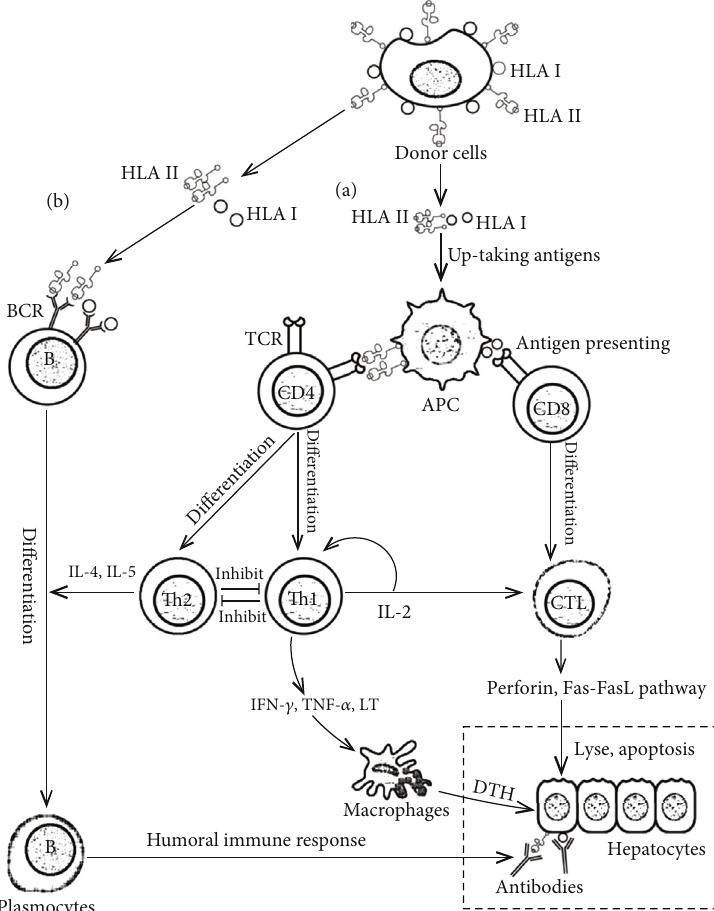
Figure 1: The mechanism of immune rejection after liver transplantation. (a) Immune rejection mediated by cellular immunity. Antigen- presenting cells (APCs) recognize and uptake the foreign antigens from donor-derived cells and present them to T cells, in which CD4+ T cells are activated and di ff erentiate into various e ff ector T cells, such as T helper 1 (Th1), Th2, and cytotoxic T lymphocytes (CTLs). Th1 cells can induce CD8+ T cells to di ff erentiate into cytotoxic T lymphocytes (CTLs) via secreting IL2, and CTLs can secrete perforin to directly lyse hepatocytes or induce target cell apoptosis through the Fas-FasL pathway. On the other hand, Th1 cells can secrete interferon-gamma (IFN- γ ), tumor necrosis factor alpha (TNF- α ), and lymphotoxin to corrupt liver grafts via delayed-type hypersensitivity (DTH), in the process of which macrophages may be a primary participant and play a critical role. (b) Immune rejection mediated by humoral immunity. B cells can directly recognize donor antigens without the antigen presentation of APC, which will be subsequently activated and di ff erentiated into plasmocytes with the help of Th2 cells, and secrete antibodies to destroy donor cells. TCR: T cell receptor; BCR: B cell receptor; HLA: human leukocyte